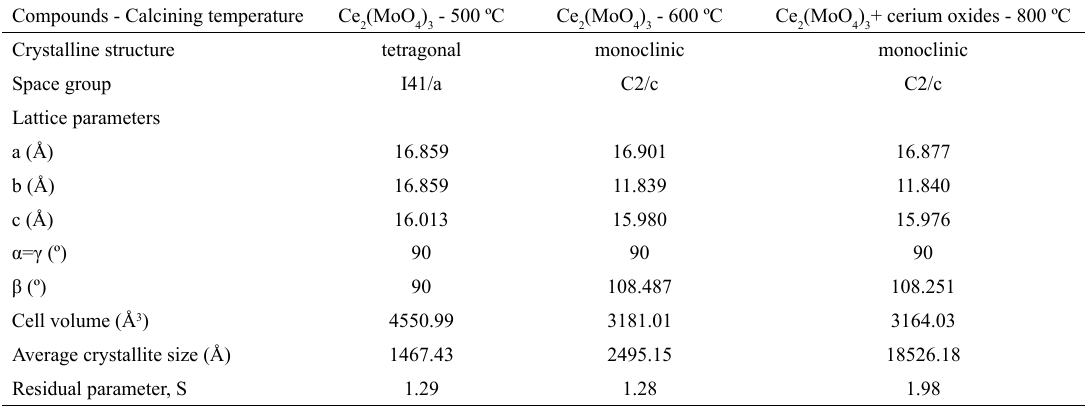
Figure 3. Observed, computed and deviation XRD patterns of Ce Table 1. Lattice parameters, cell volume and average crystallite size from Rietveld refinement of X-ray diffraction data of the samples calcined at 500, 600 and 800